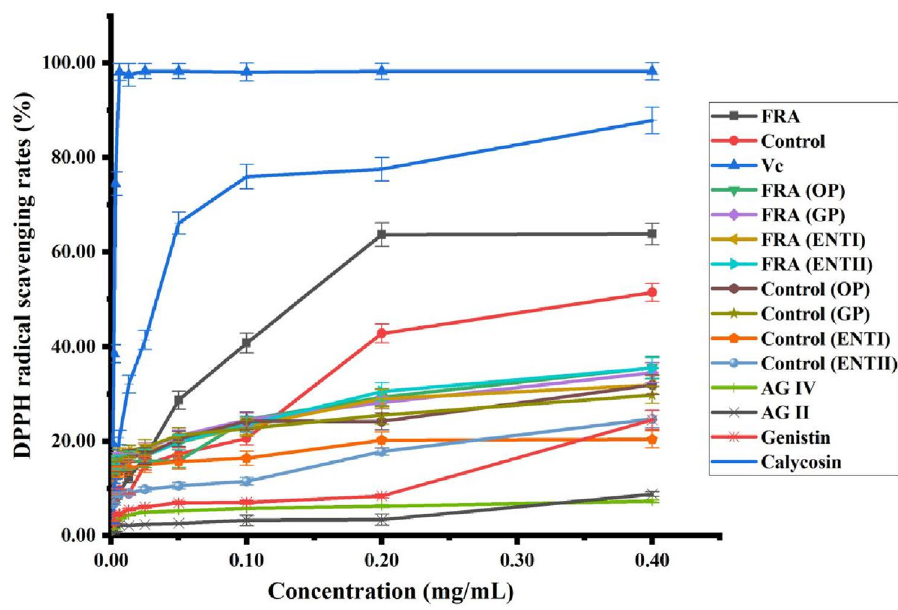
Figure 3. DPPH radical scavenging rate of each sample of Radix Astragali, standards and